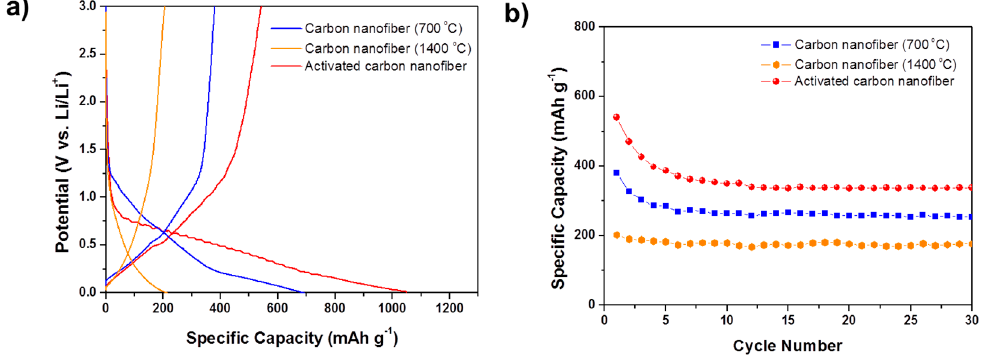
Figure 4. Electrochemical behaviors of the various types of carbon nanofibers: ( a ) Initial charge/discharge curves and ( b ) Cycle performance of the carbon nanofiber electrodes at a cycling rate of 0.1 C.